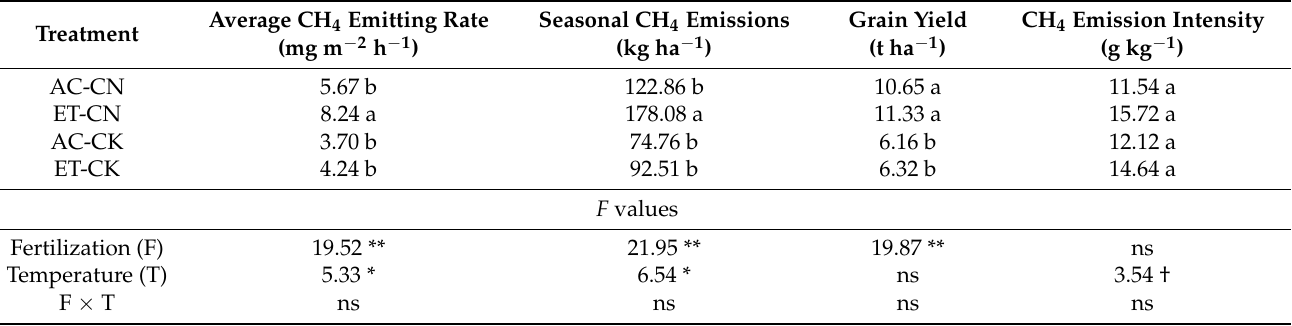
Figure 1. Paddy CH 4 emitting rate (means ± se) as affected by temperature and fertilization. AC, ambient control; ET, experimental warming; CN, fertilization treatment; CK, no N-fertilizer input treatment. Table 1. The average CH 4 emitting rate, seasonal emissions, rice grain yield and CH 4 emission intensity.